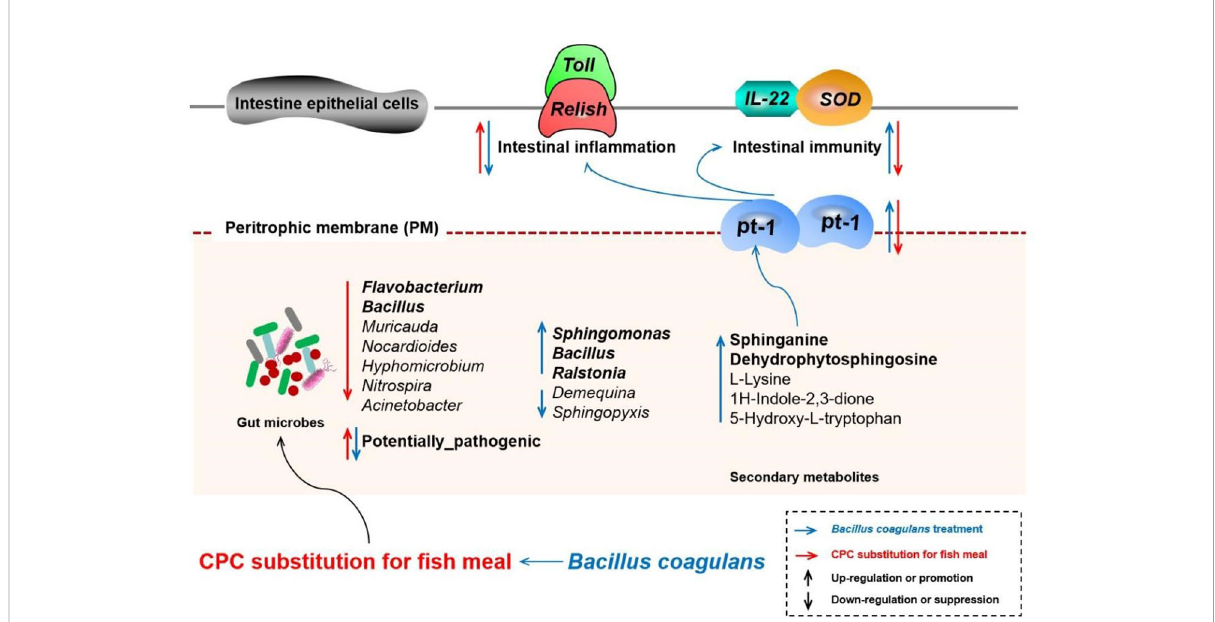
FIGURE 10 Schematic diagram depicting the effects and possible mechanisms of the effects of CPC substitution and Bacillus coagulans intervention on gut microbes, derived secondary metabolites, and intestinal physiological functions of Macrobrachium rosenbergii . The red arrow represents the action path of CPC substitution, and the blue arrow represents the action path of Bacillus coagulans intervention. The upward arrow represents upregulation or promotion, and the downward arrow represents downregulation or suppression. CPC, cottonseed protein